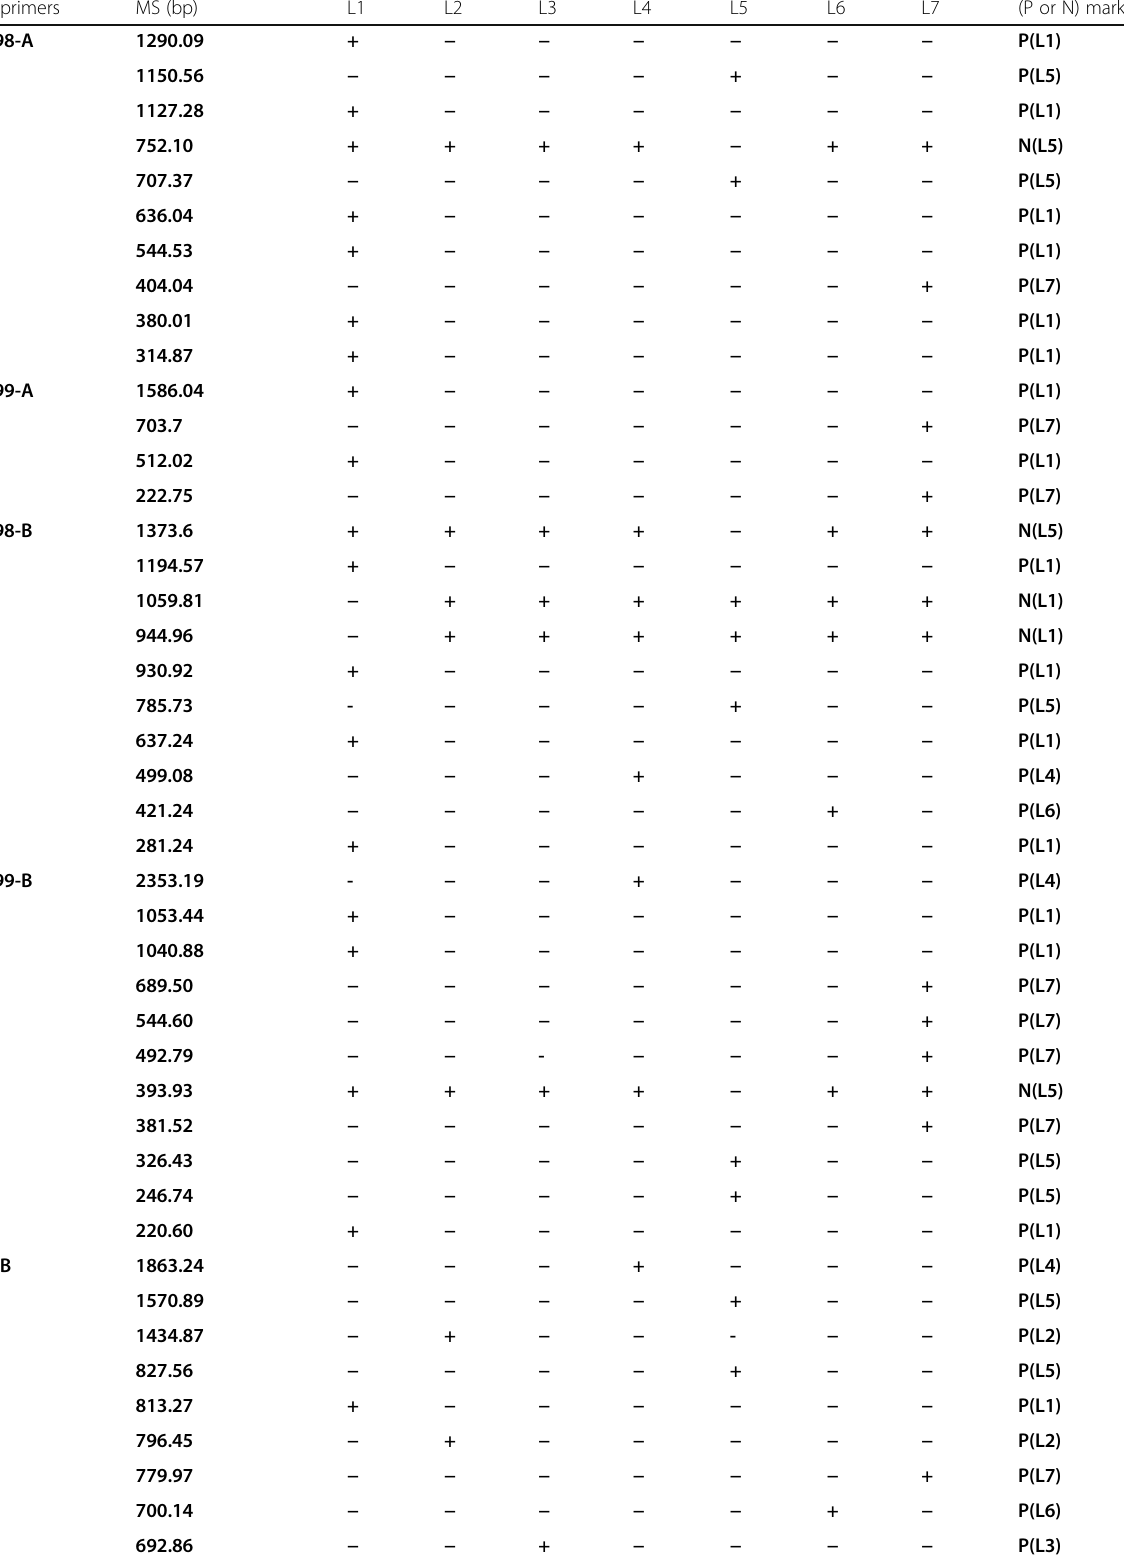
Table 8 Mapping of positive (P) and negative specific markers for the 7 wheat lines using six ISSR